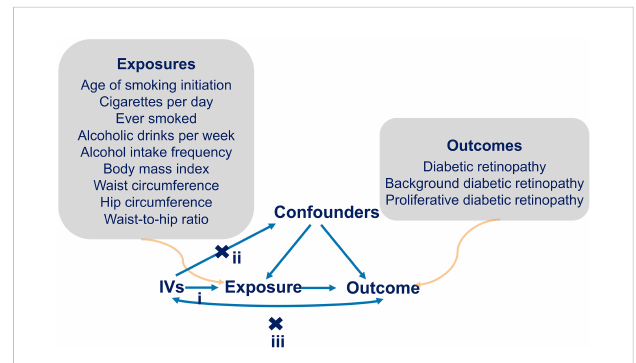
FIGURE 1 Diagram of MR assumptions. i): represents the IVs need to be related with the exposures robustly. ii): represents the IVs in fl uence the outcome only through the exposures of interest. iii): represents the IVs are independent of any confounders of the exposure-outcome relation. Arrows interpret the causal relationships among variables.